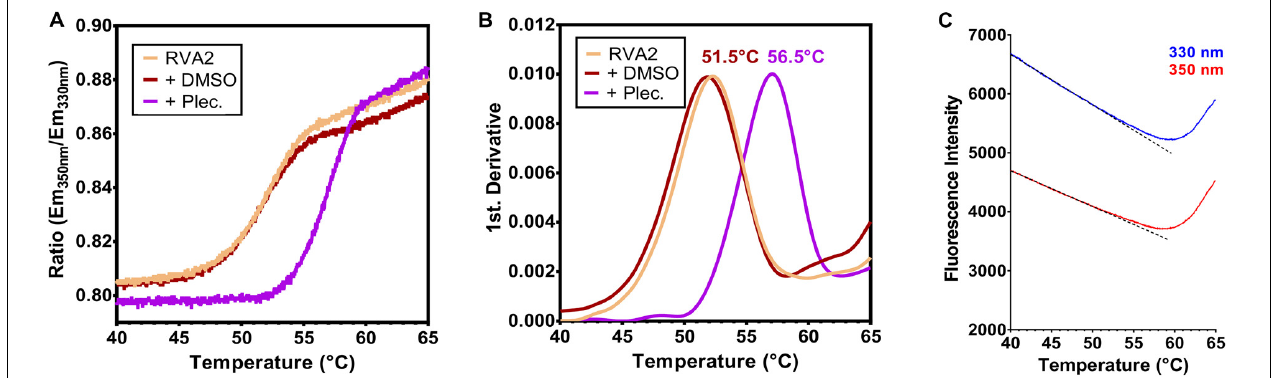
FIGURE 3 | nanoDSF demonstrates the thermostabilization of RV-A2 by pleconaril. Purified RV-A2 was diluted in PBS (1 mg/ml) ± 1 mM pleconaril (Plec.) and analyzed by nanoDSF. The heating rate was 1 ◦ C/min and tryptophan fluorescence was recorded in steps of ∼ 0.02 ◦ C. (A) Ratio Em 350nm /Em 330nm plotted against the temperature. The steeper sigmoidal curve in the presence of pleconaril relates to the faster transition of native (N) to A particles at a higher temperature after the drug has been thermally expelled from the pocket. Orange trace, untreated virus; brown trace, DMSO treated virus (solvent control “+DMSO”); purple trace, pleconaril treated virus (“+Plec”). (B) The first derivative of the curves in panel (A) . The temperature where 50% of the virus has converted into A particles is indicated, which is shifted by ∼ 5 ◦ C to the right in the presence of the capsid-stabilizing compound. The curves represent the mean of three independent measurements. (C) Raw 350 and 330 nm emission curves of purified RV-A2 treated with pleconaril used for ITF Ratio calculation in panel (A) . Dotted straight lines represent the pretransition baseline obtained by data fitting. The overall profile is similar to Figure 2C , though the onset of A into B particle conversion (the left minimum of the Em 330nm and Em 350nm curves) is shifted by about 5 ◦ C to higher